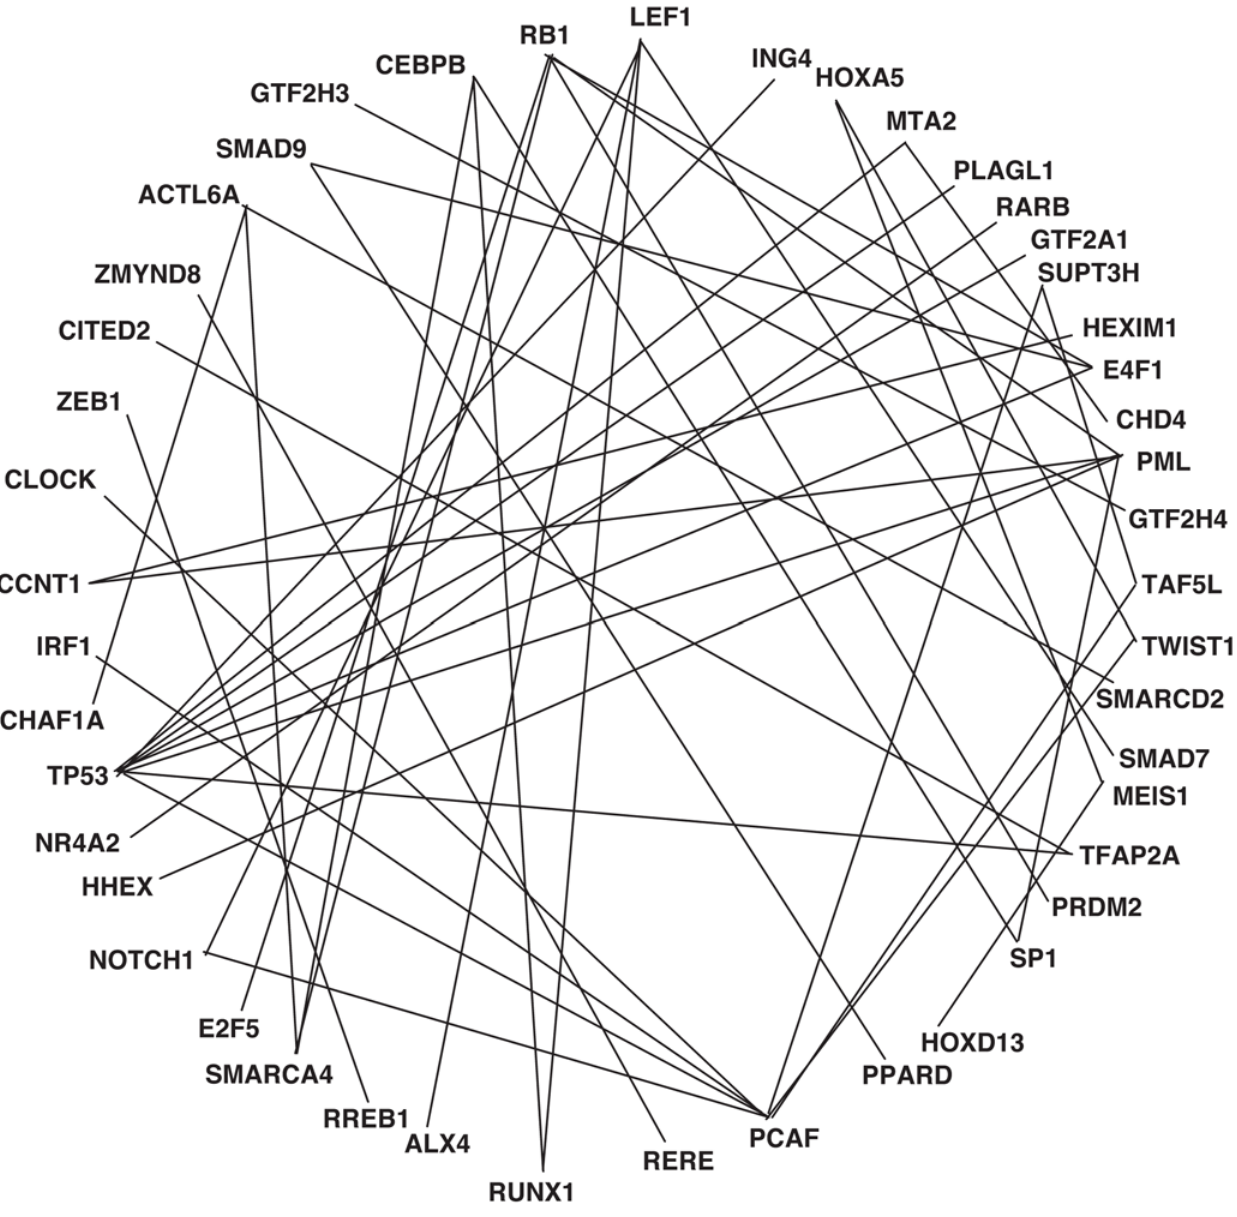
Figure 4. An inner core of p63 transcriptional targets. Schematic representation of the documented interaction of the different p63 transcriptional